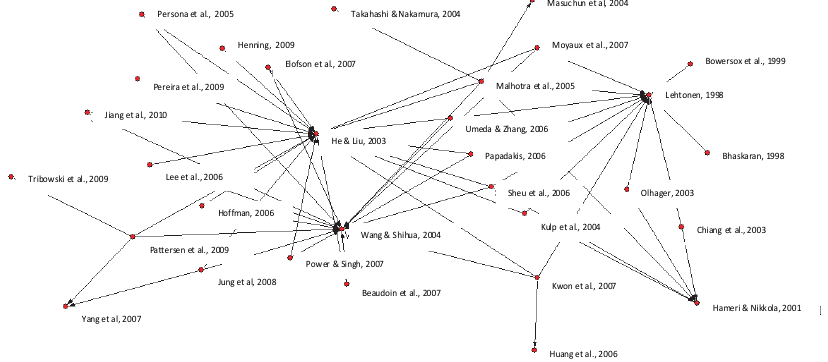
Fig. 2. Reporting on static and dynamic interaction in the management of SCs: Citation Network of relevant (>20 citations) trends for the WoS database in SC